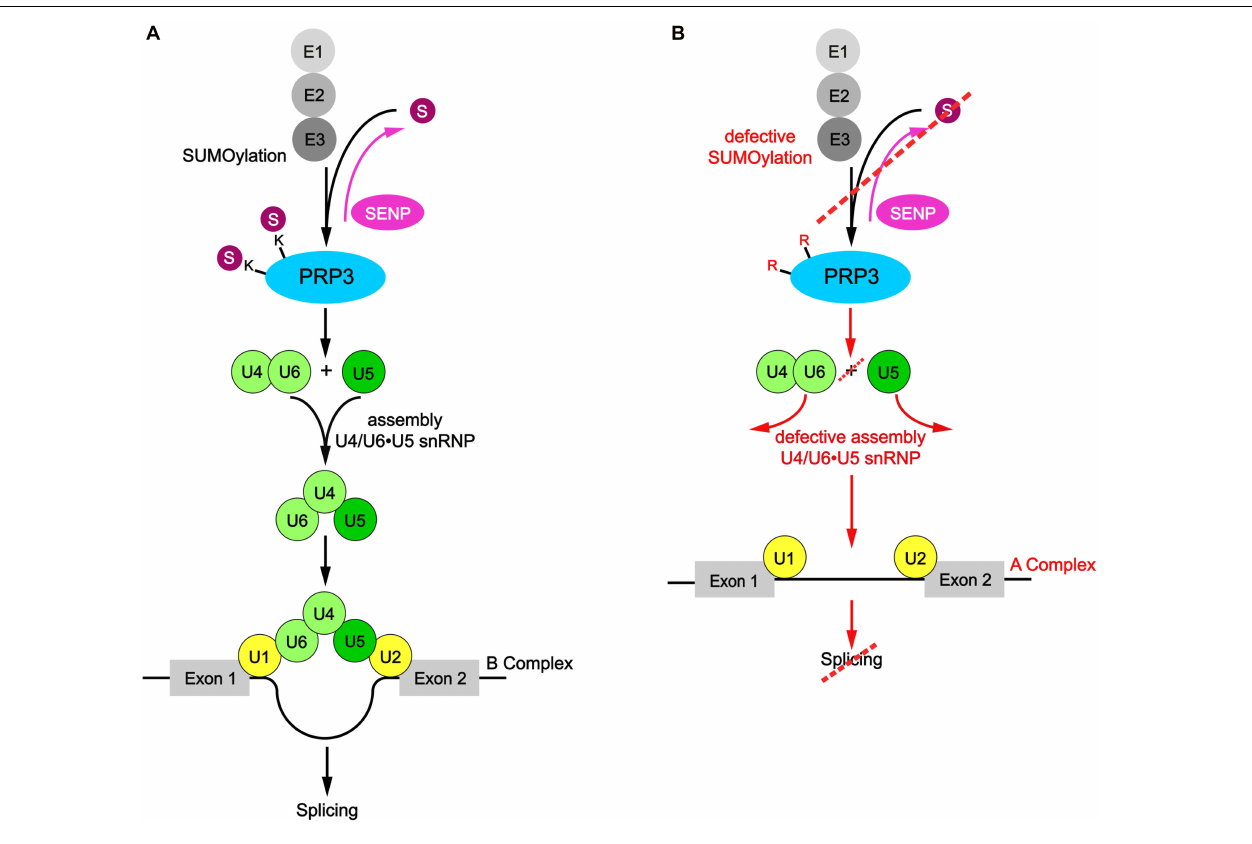
FIGURE 2 | SUMOylation of PRP3 promotes U4/U6U5 tri-snRNP formation. (A) The human PRP3 protein, as a component of the U4/U6 di-snRNP, is a SUMOylation target and promotes U4/U6U5 tri-snRNP formation to convert the A complex into the active B complex by interacting with U2 and U5 thereby promoting the splicing process. (B) After mutation of the relevant lysine residues into arginine, the SUMO-deficient PRP3 fails to co-precipitate U2 and U5 snRNAs resulting in hampered U4/U6U5 tri-snRNP assembly and shows diminished recruitment to splice sites indicating that SUMOylation of PRP3 promotes U4/U6U5 tri-snRNP